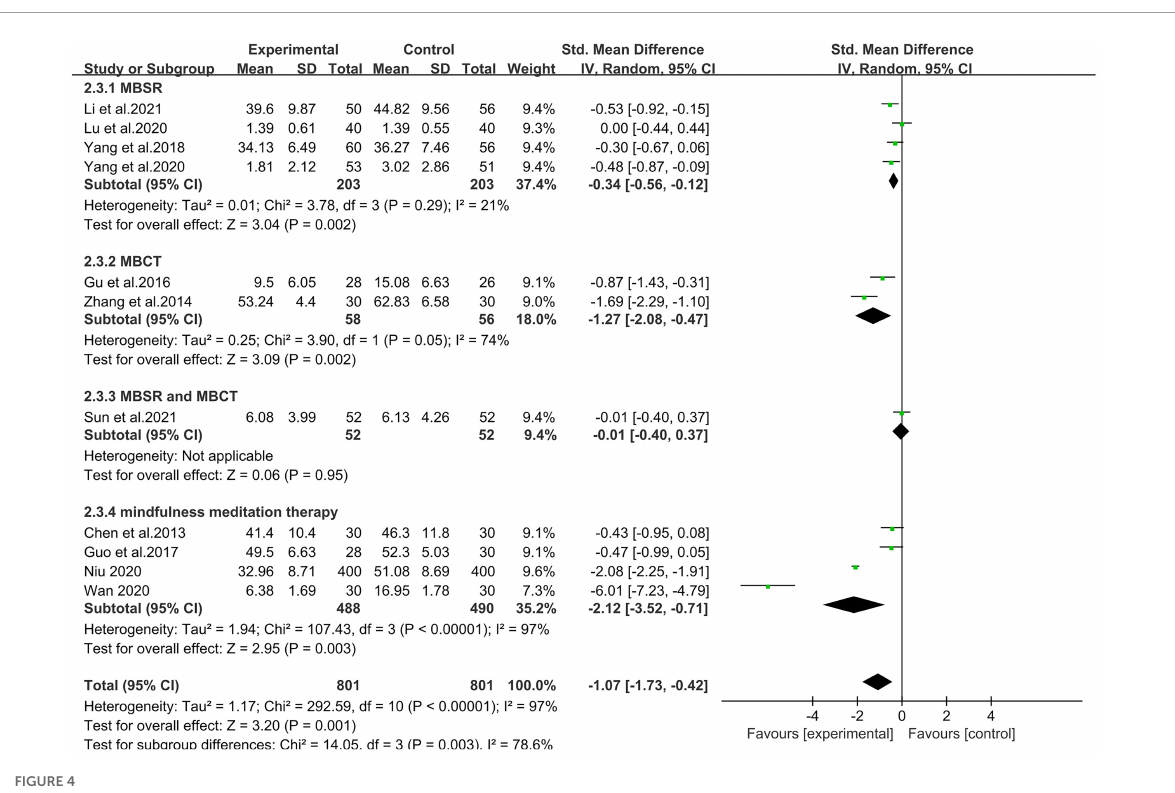
FIGURE4 Forest plot of effects of mindfulness intervention based on intervention